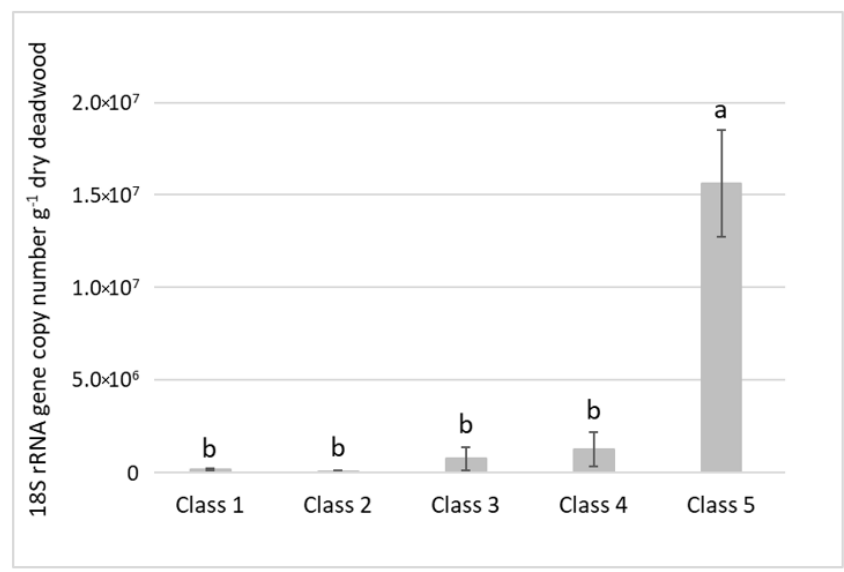
Figure 4. Quantification of the ciliate community in black pine deadwood samples of the different decay classes collected from the Pratomagno area. Bars indicate standard error. The different letters over the histograms indicate significant differences among means ( p <